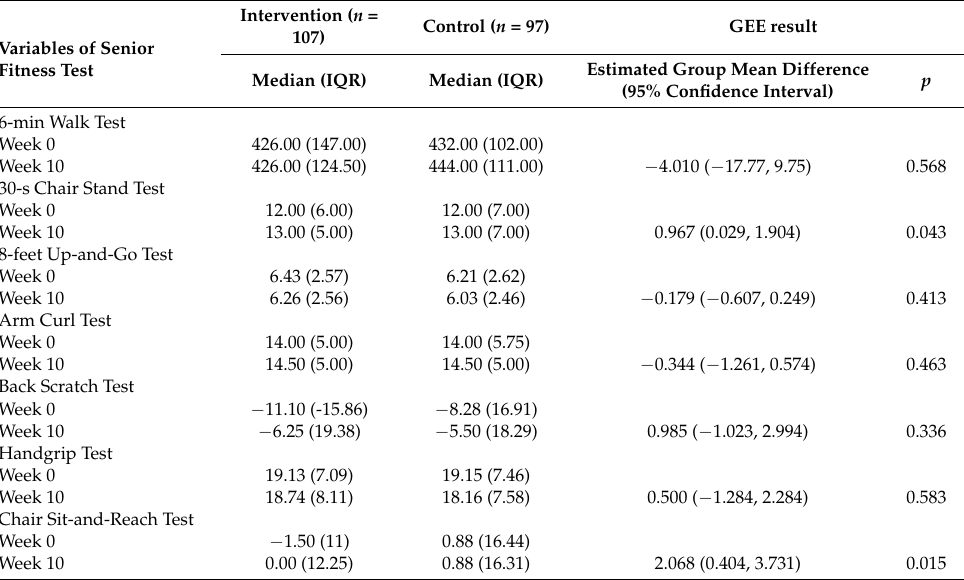
Table 3. GEE results of fitness test between IG and